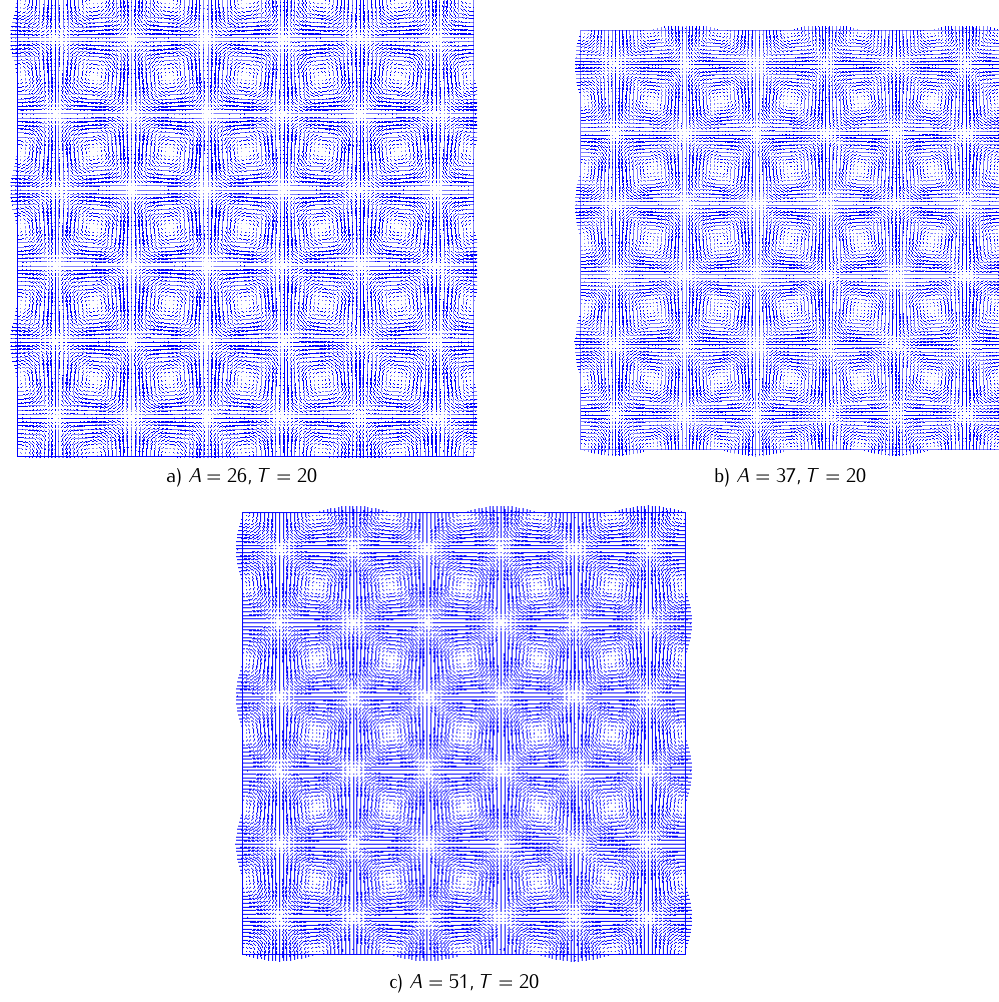
= 0 . 05 . We show the behavior of the computed vector at T = 20 . The electric vector field for different values FEM